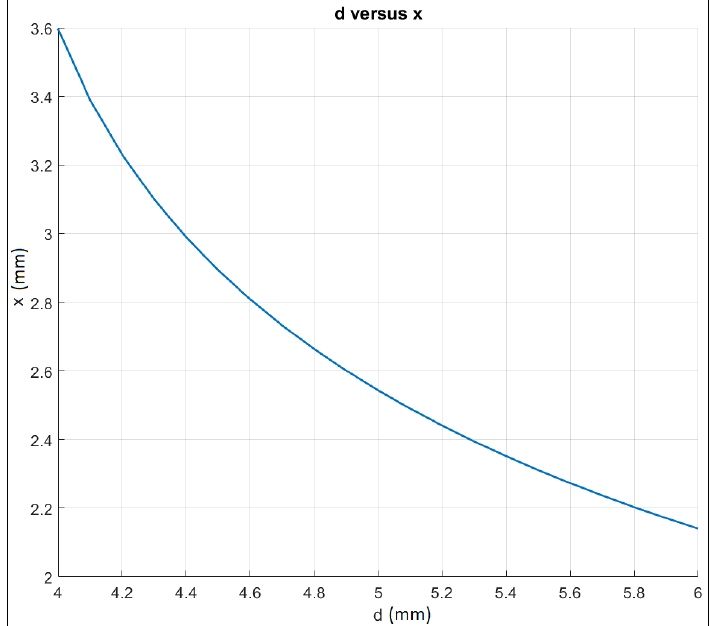
Figure 5. Shifting x versus distance